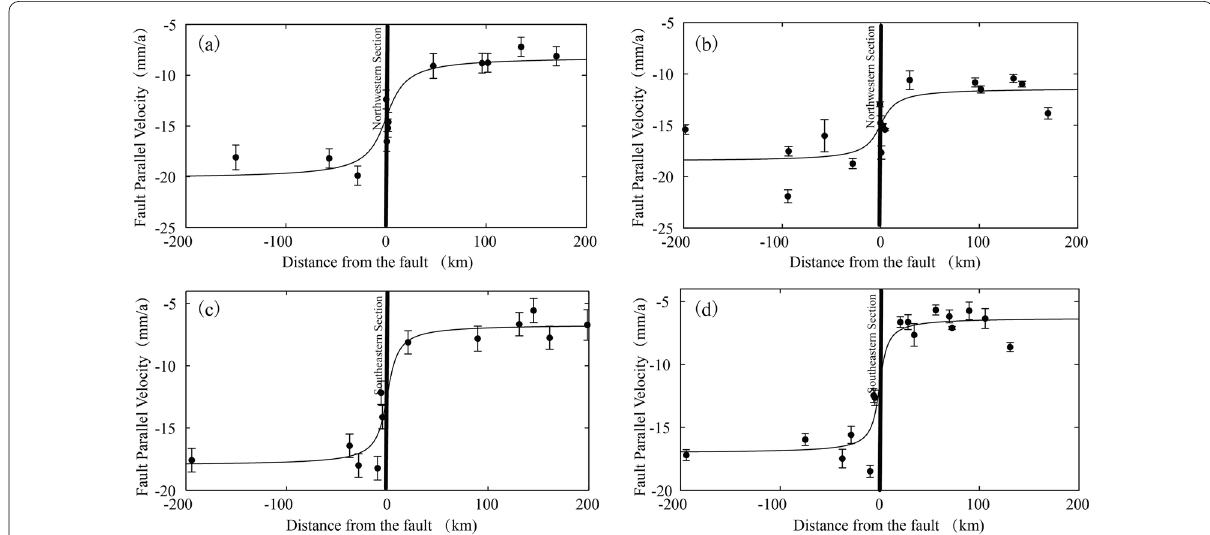
Fig. 6 GNSS velocity profiles across the Xianshuihe Fault Zone. a and b The velocity parallel to the northwestern section of the Xianshuihe Fault Zone during 1999–2007 and 2016–2020; and c and d the velocity parallel to the southeastern section of the Xianshuihe Fault Zone